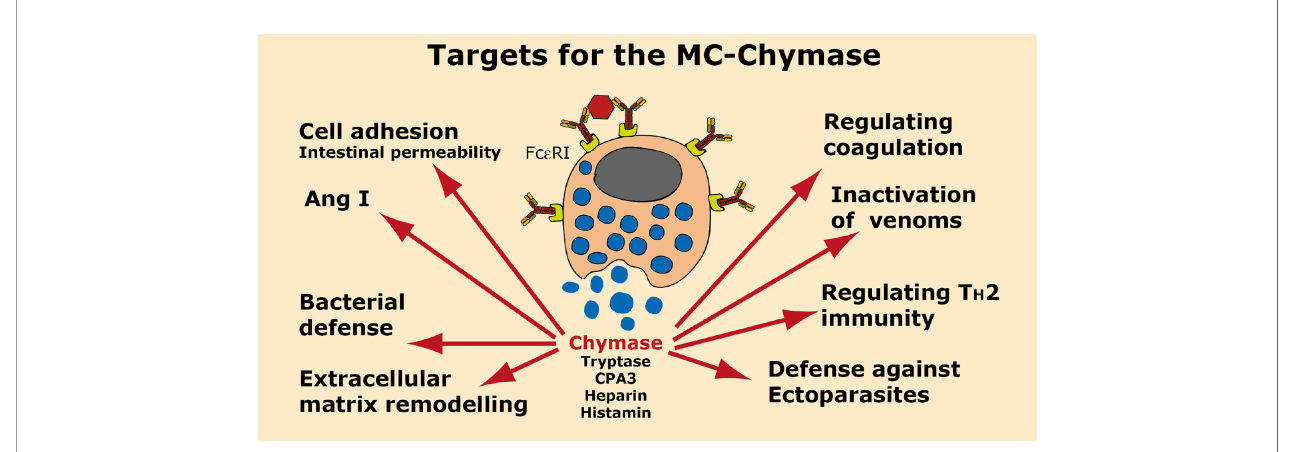
FIGURE 6 | Targets for the human MC-Chymase. A number of potential targets for the human MC chymase is